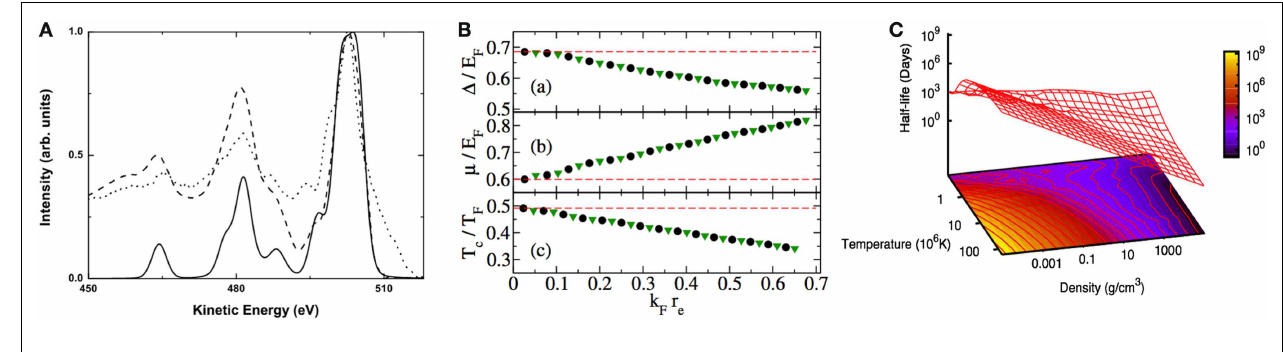
Fermi momentum k F times the effective range r e . Dots and triangles FIGURE 1 | (A) Si K-LL Auger spectrum. Black line: ab initio spectrum. Dashed line: spectrum with added extrinsic features. Point line: refer to the narrow and broad resonances, respectively.The dashed experimental spectrum. (B) Pairing function ∆ (A) , chemical potential horizontal lines report the same quantities calculated using the contact µ (B) , and phase transition temperature T potential. (C) Electron-capture decay rate in days for 7 Be as a function c (C) for an ultracold Fermi gas of 6 Li atoms at unitarity (BEC–BCS crossover) as a function of the of ρ and T